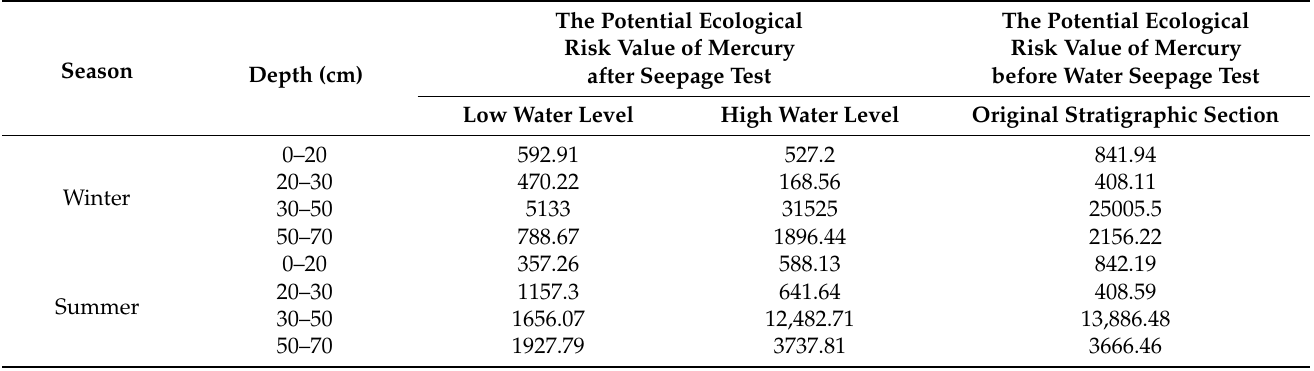
Table 5. The potential ecological risk value of mercury in the subsurface zone under the condition of changing river water